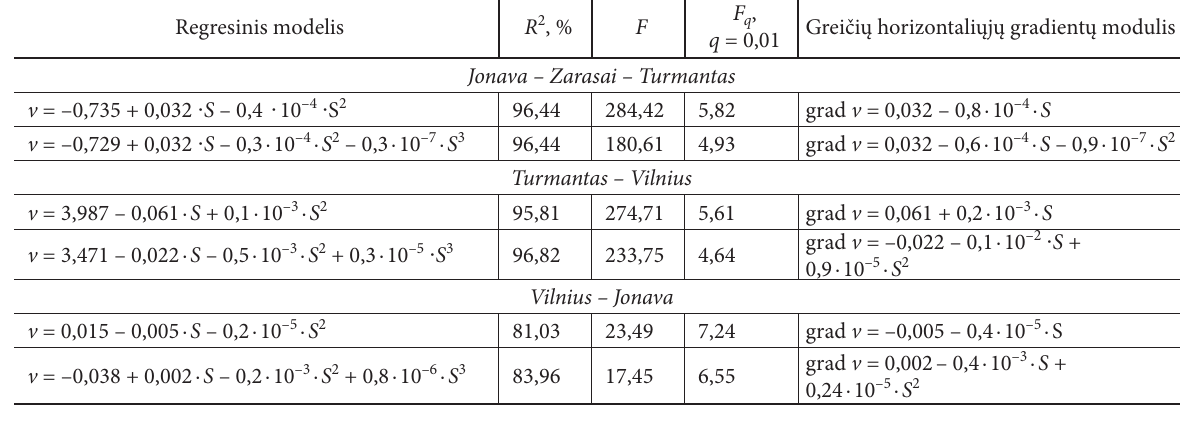
Table 1. The models of multi-component regression and the models of horizontal velocity gradients of the vertical movements of the Earth’s crust